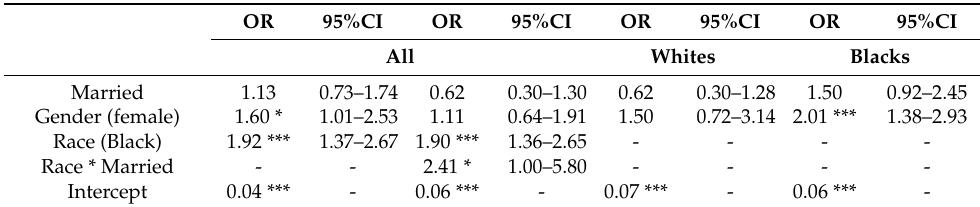
Table 4. The results of four logistic regression models in the pooled sample and across races on the separate effect of family structures on subsequent SRH in the youths at age 15.